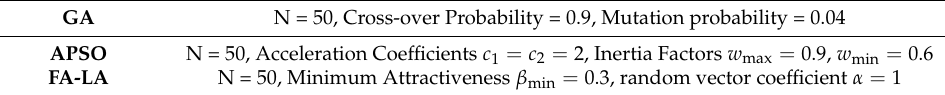
Table 3. Parameter settings in competitor algorithms.